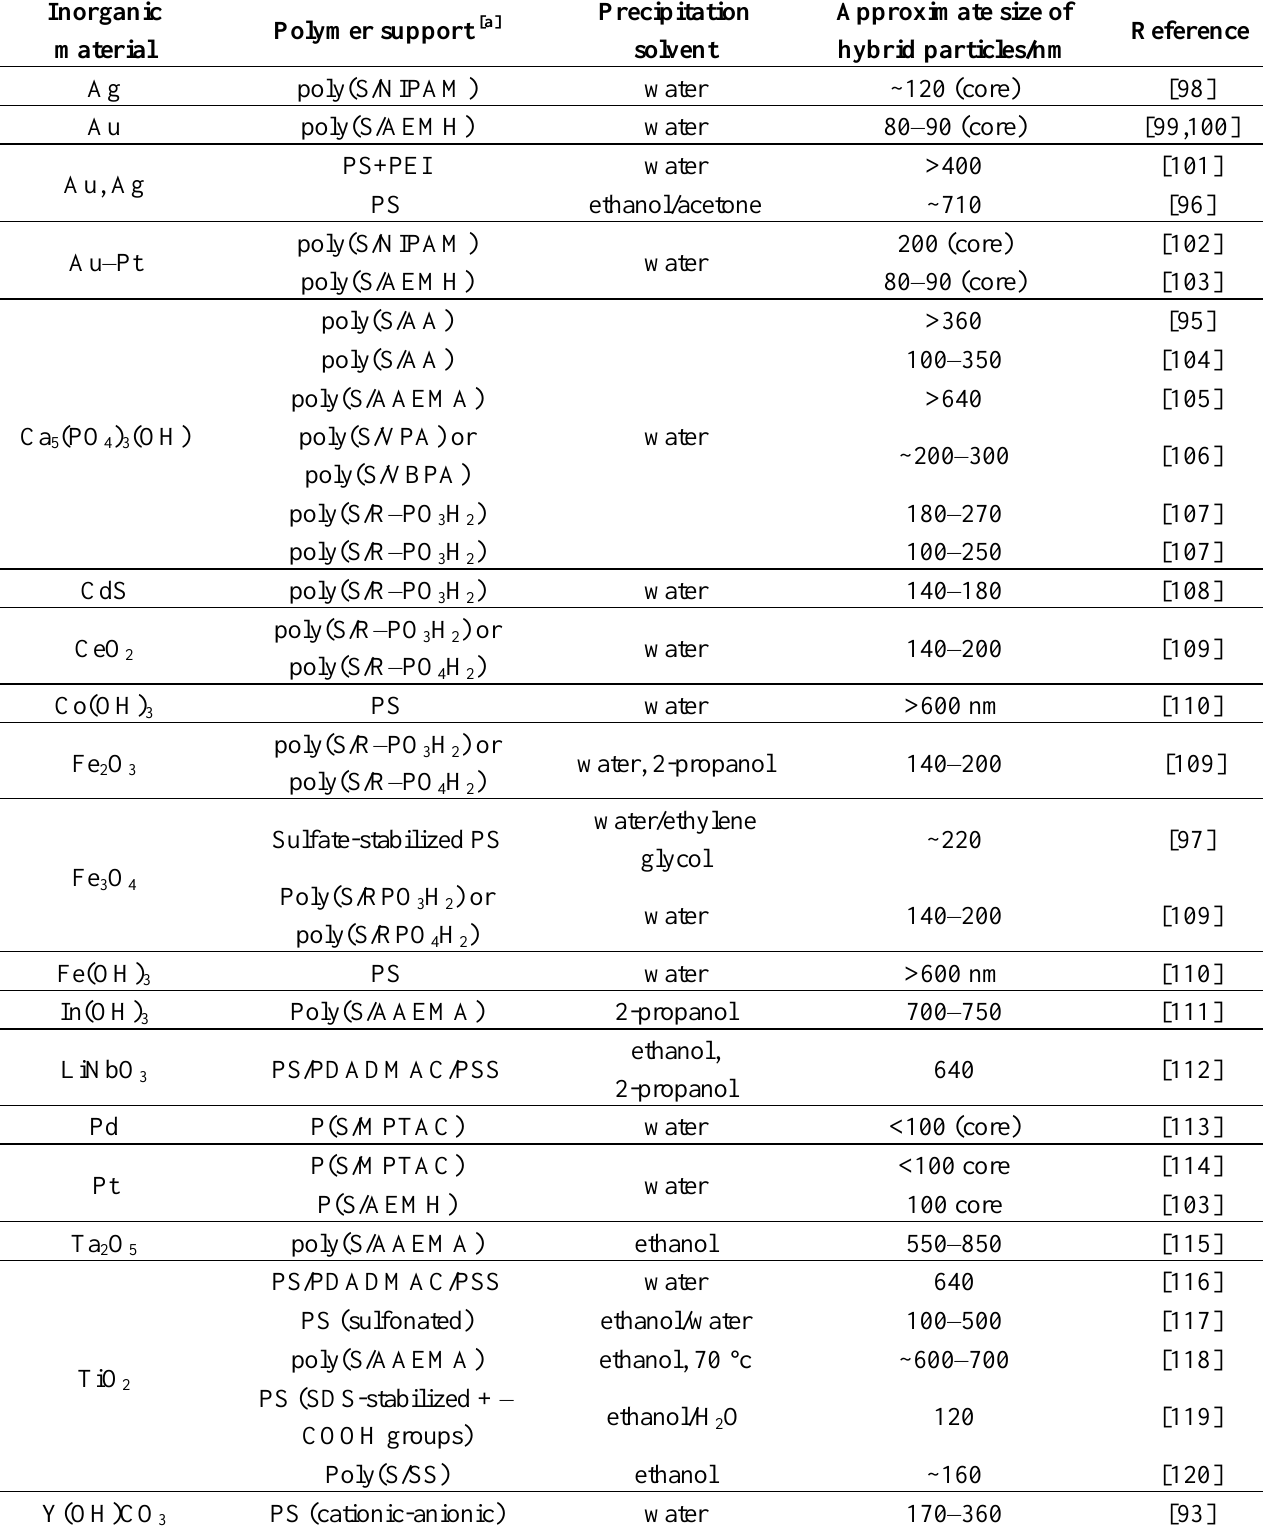
Table 2. Representative works on the formation of polymer/inorganic hybrid particles by in situ precipitation of inorganic materials on the surface of colloid polymer